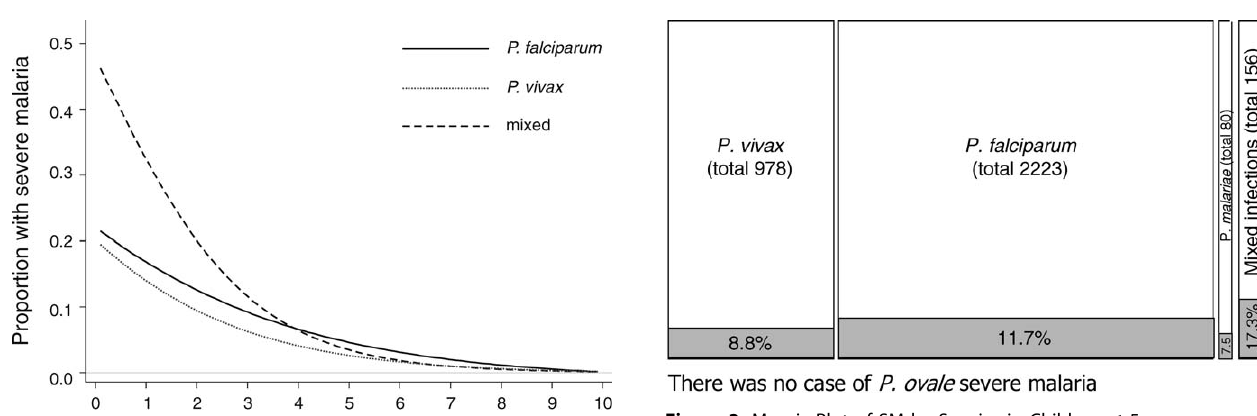
Figure 3. Mosaic Plot of SM by Species in Children , 5 y Horizontal, species; vertical, proportion of SM.